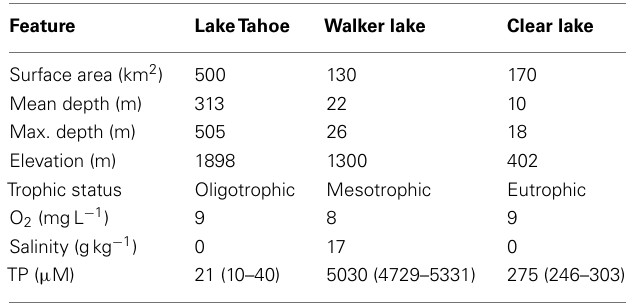
Table 1 | General characteristics of the lakes studied (LakeTahoe, Walker Lake, and Clear